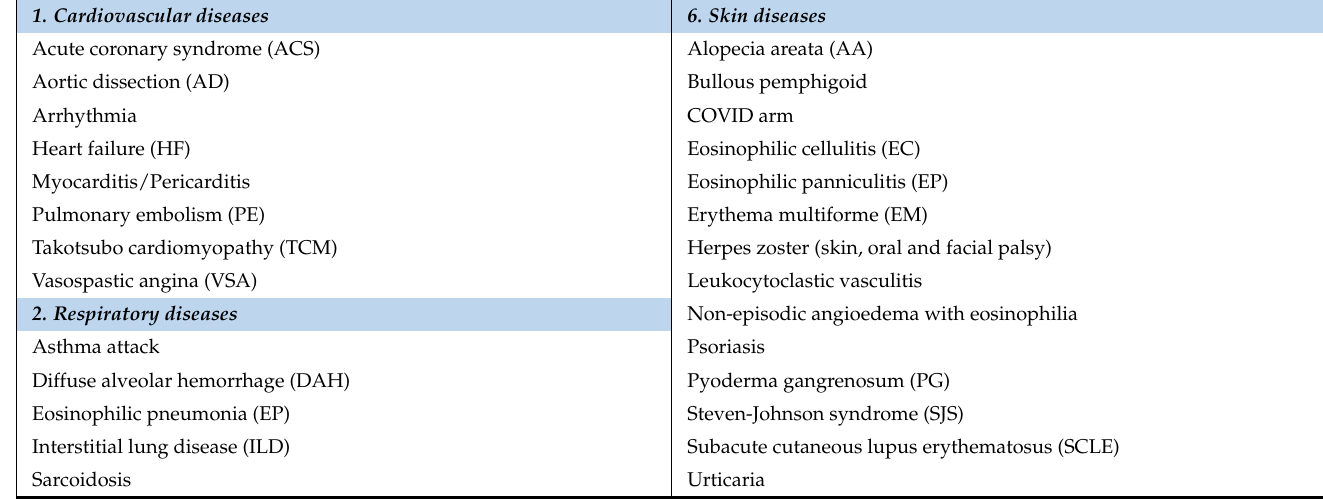
Table 1. Organ-specific diseases associated with the COVID-19